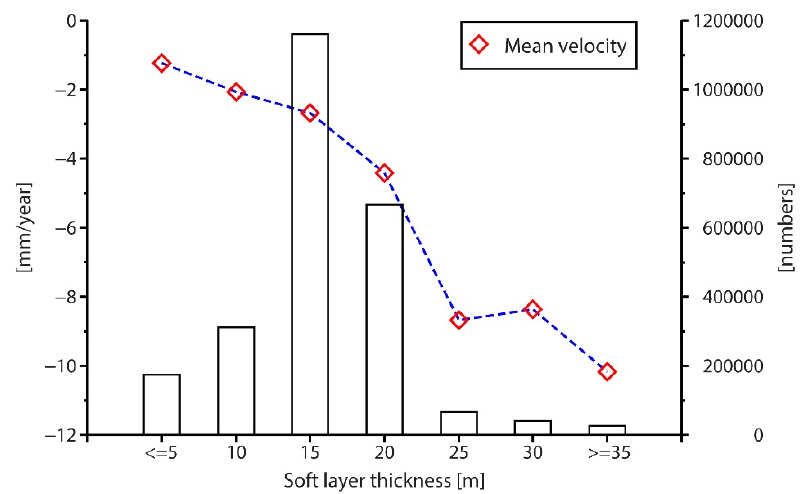
Figure 6. Relationship between soft soil thickness and mean vertical velocity. The white bars represent the number of pixels and the red diamonds represent the calculated mean velocity for each soft soil thickness interval.